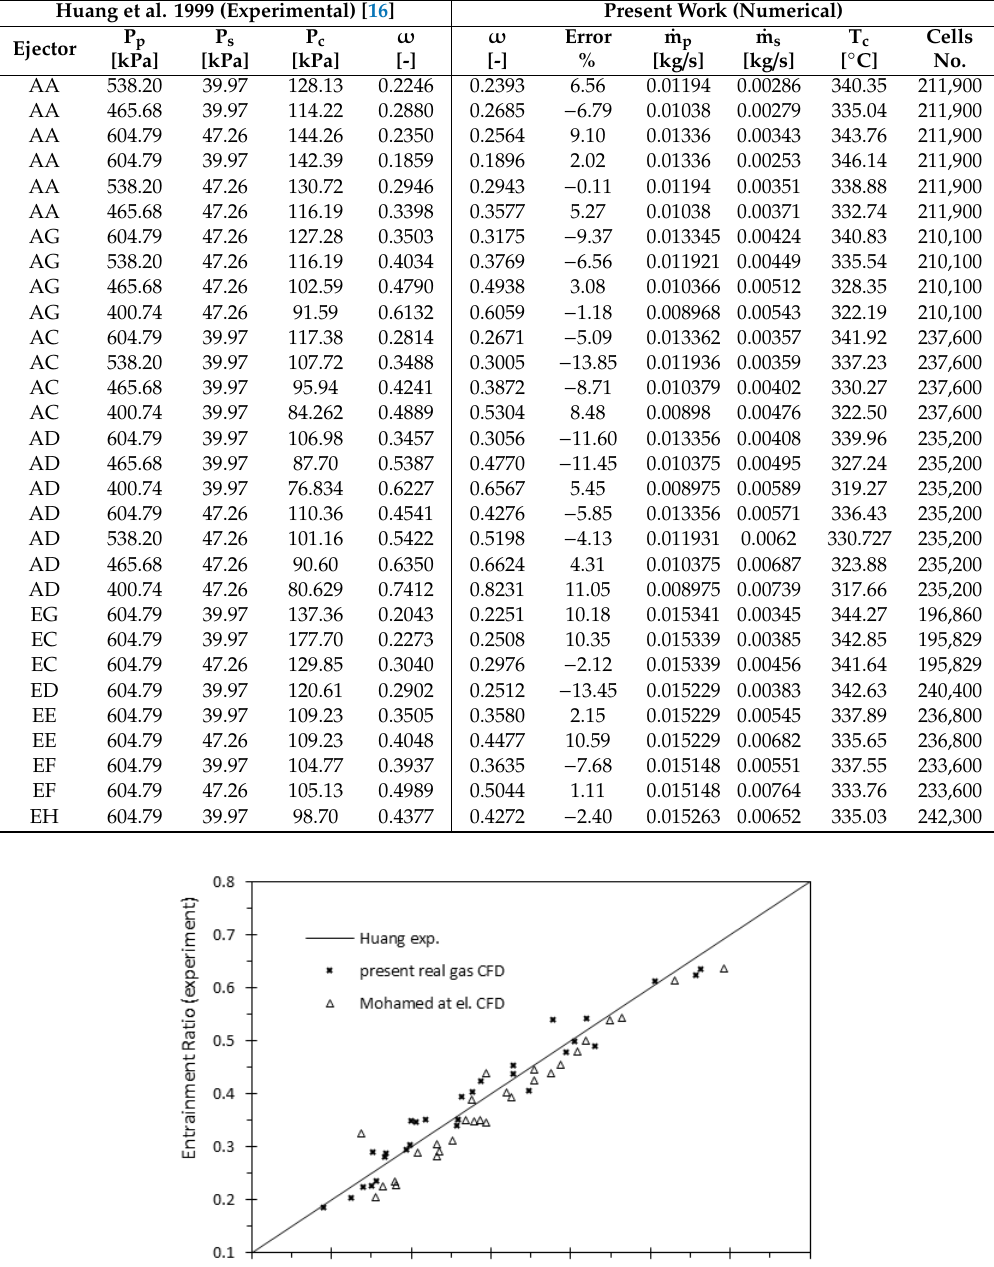
Table 2. Verification of the CFD results with Huang et al. experimental results.